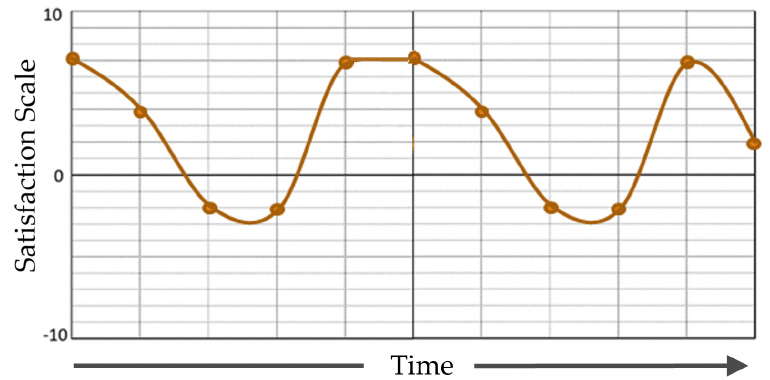
Figure 2. Example of a UX Curve.